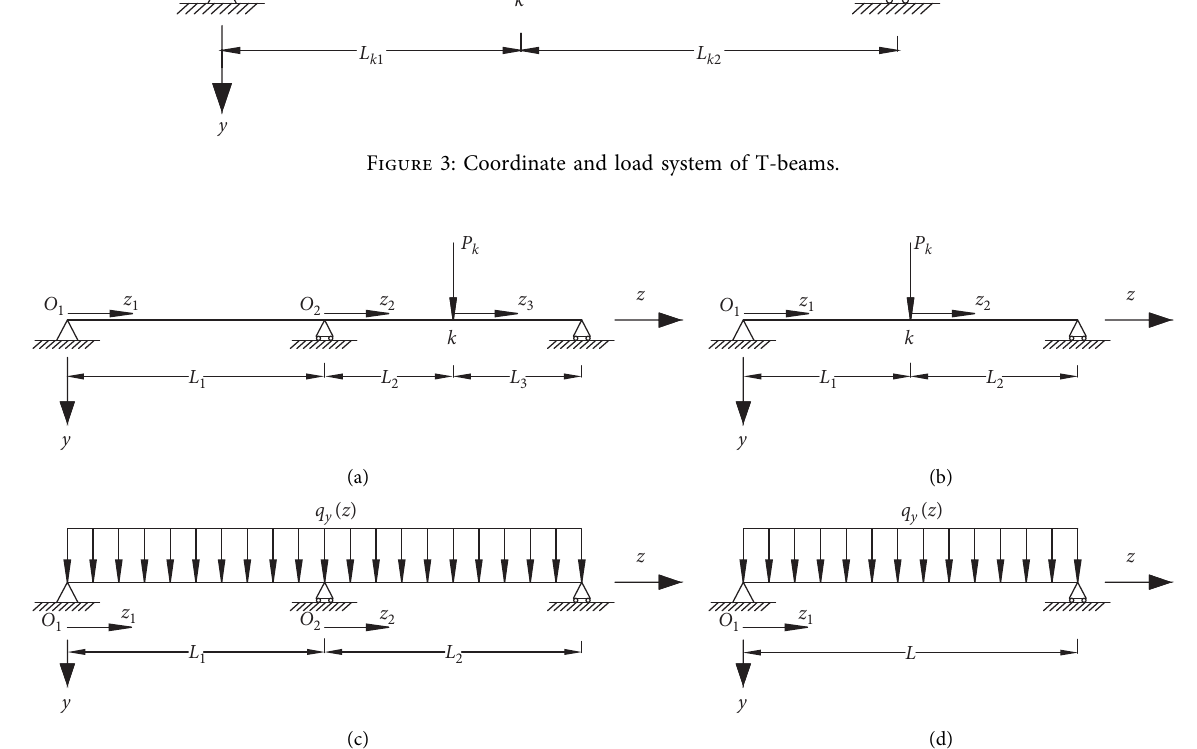
Figure 4: Boundary conditions and load systems for the mechanical analysis of T-beams: (a) two-span continuous T-beam with con- centrated load; (b) simply supported T-beam with concentrated load; (c) two-span continuous T-beam with uniform load; (d) simply supported T-beam with uniform Table 1: Stress of the flange for two-span continuous T-beams ( L